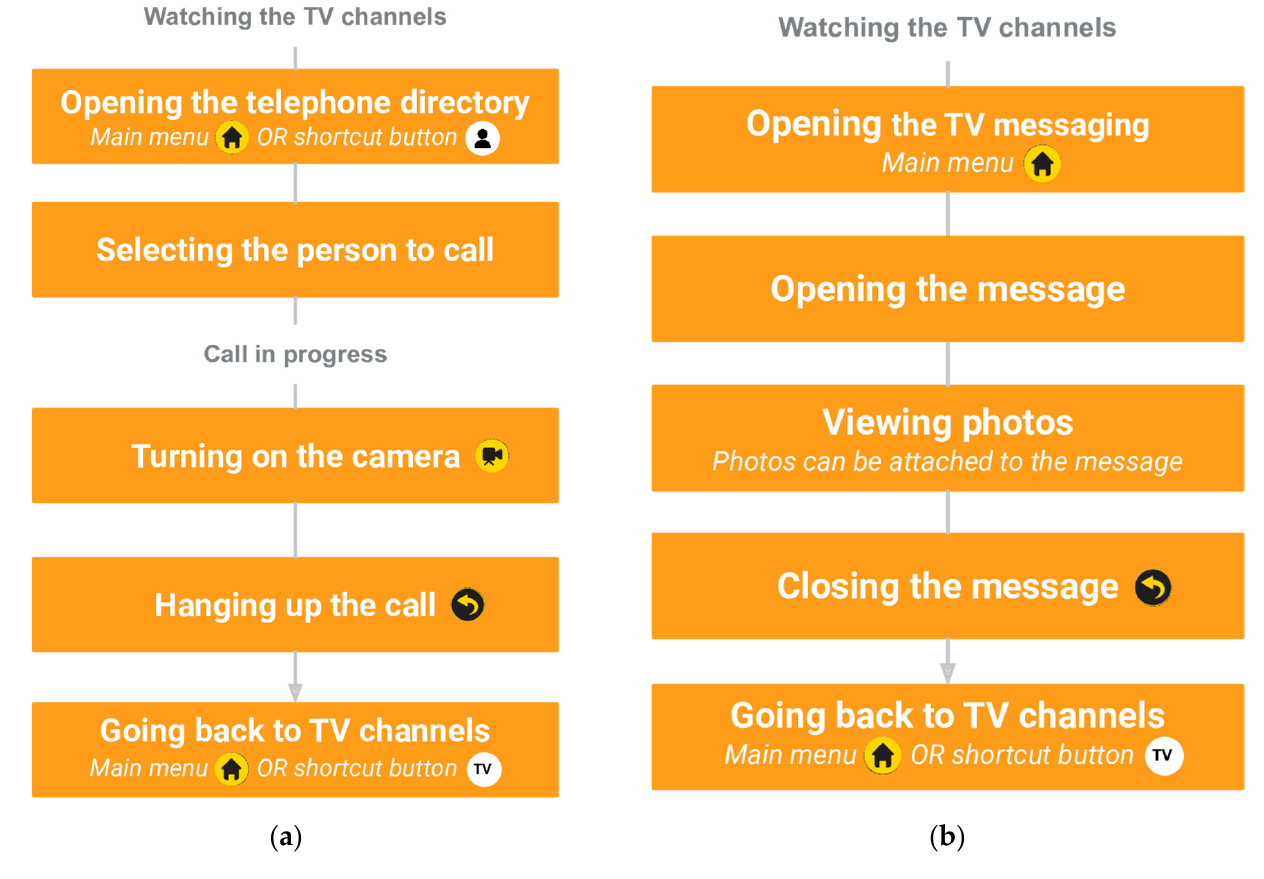
Table 1. Interview guide used for semi-structured interviews with residents.